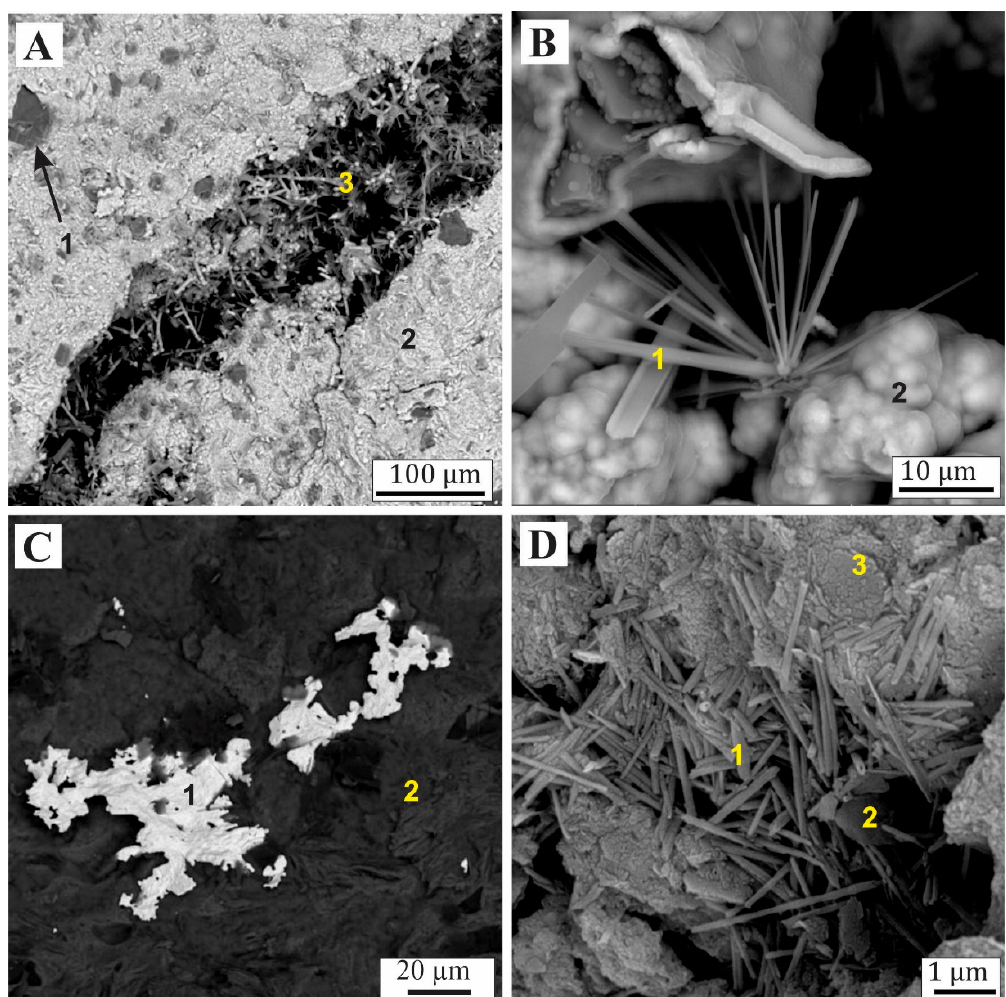
Figure 8. SEM micrographs of internal surface of a broken ferruginous nodule formed in the Wollubar Sandstone (NWS) and saprolite (NSP) showing textures of various minerals in the core. (A) The core of the NWS showing quartz grains (1) cemented by goethite (2) and needle-shaped chromite growing into a cavity (3). (B) Close-up of chromite needles (1) and botryoidal goethite (2). (C) multiple secondary Au particles (1) in a goethite matrix (2) of the NWS. (D) The core of NSP showing tubular crystals of halloysite (1), platy crystals of kaolinite (2) and fine-grained spherical to platy goethite (3).